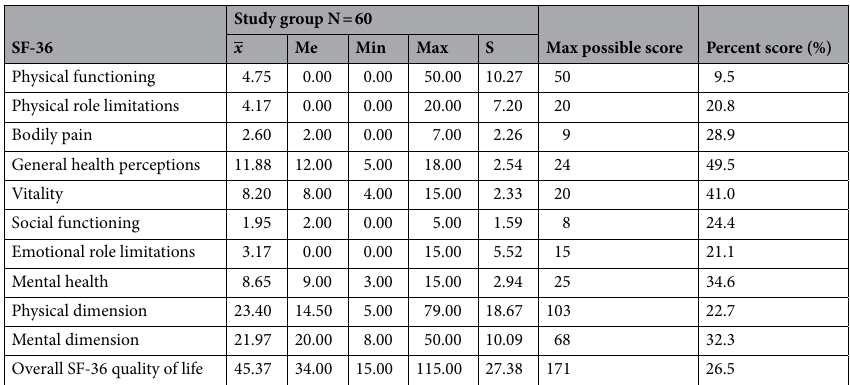
Table 2. Characteristics of the subjects’ quality of life, assessed with SF-36 questionnaire. x mean, Me median, S standard deviation, Min minimum value, Max maximum